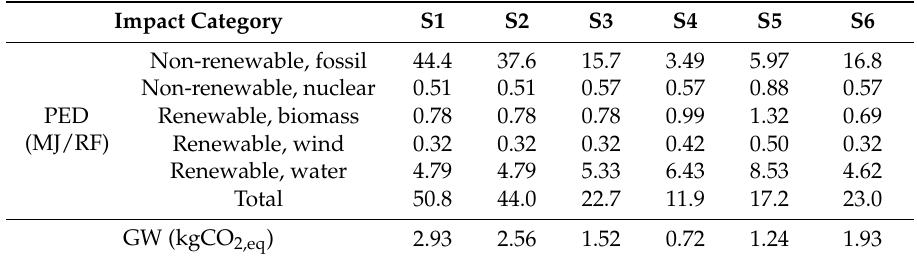
Table 3. Impacts related to primary energy demand (PED) (by subcategory and total impact) and global warming (GW) for scenarios